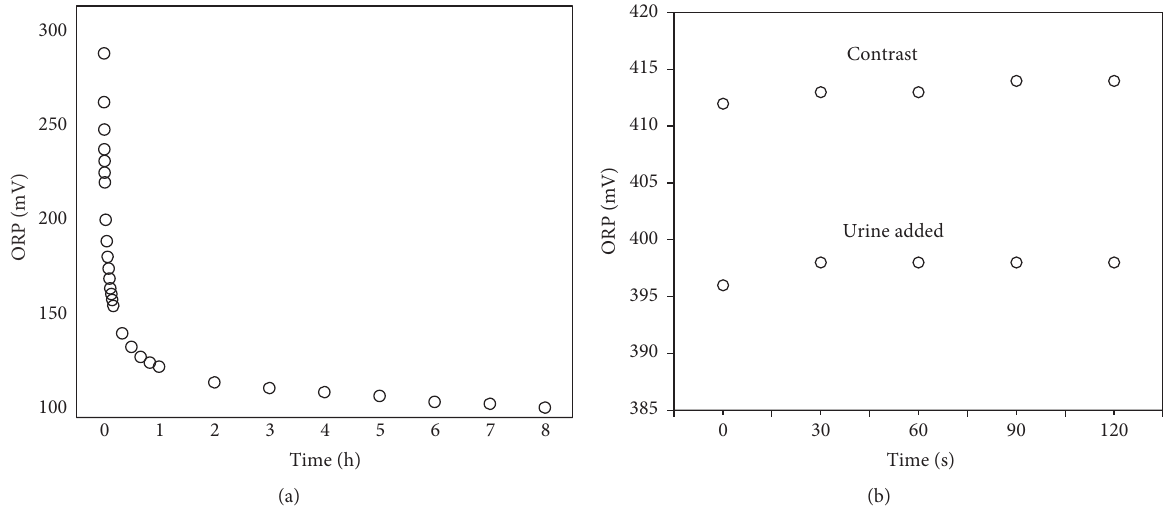
Figure 1: Changes in the values of ORP over time by the direct method (a) and by the I 2 /KI electrode method (b).